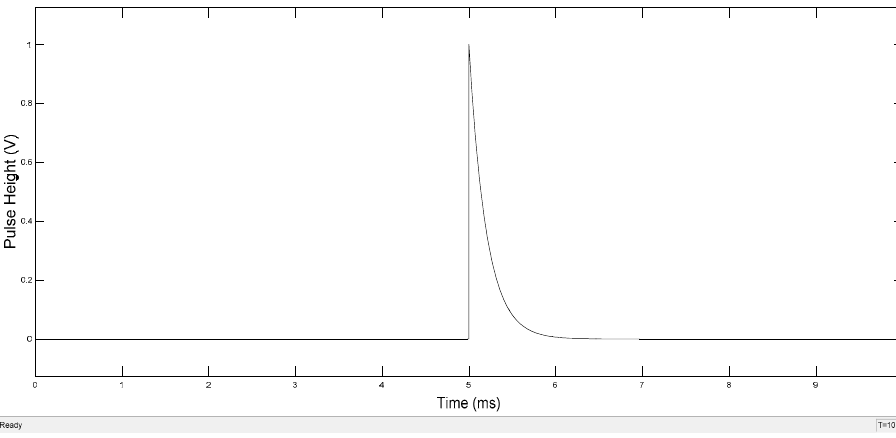
Figure 4. Trapezoidal pulse synthesis.